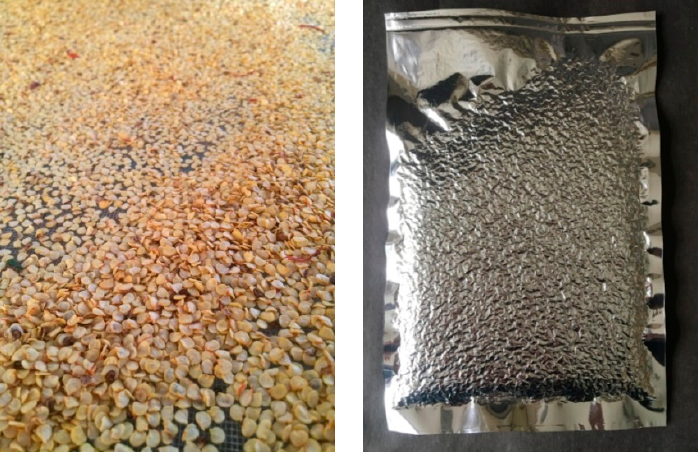
Figure 2. Extracted seeds of pepper and hermetically laminated aluminum foil pack.